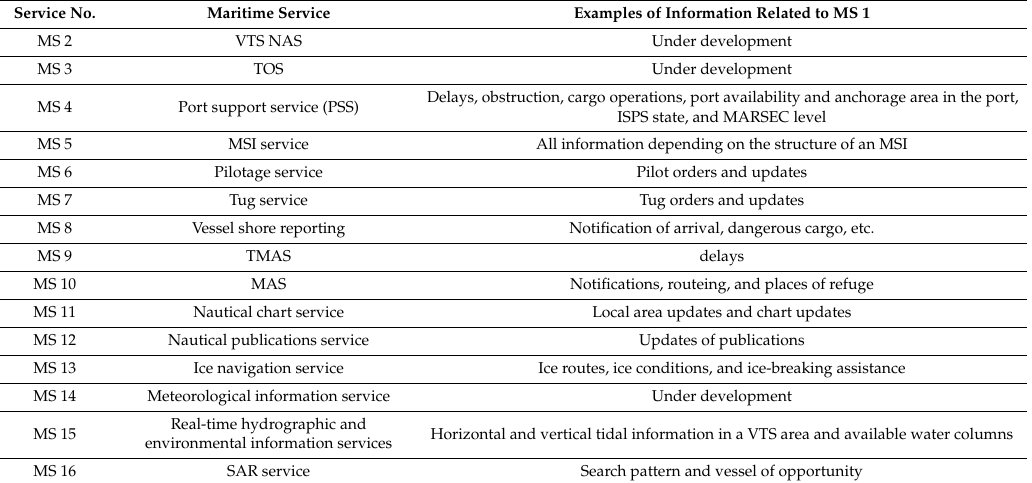
Table 3. Relations to other maritime services